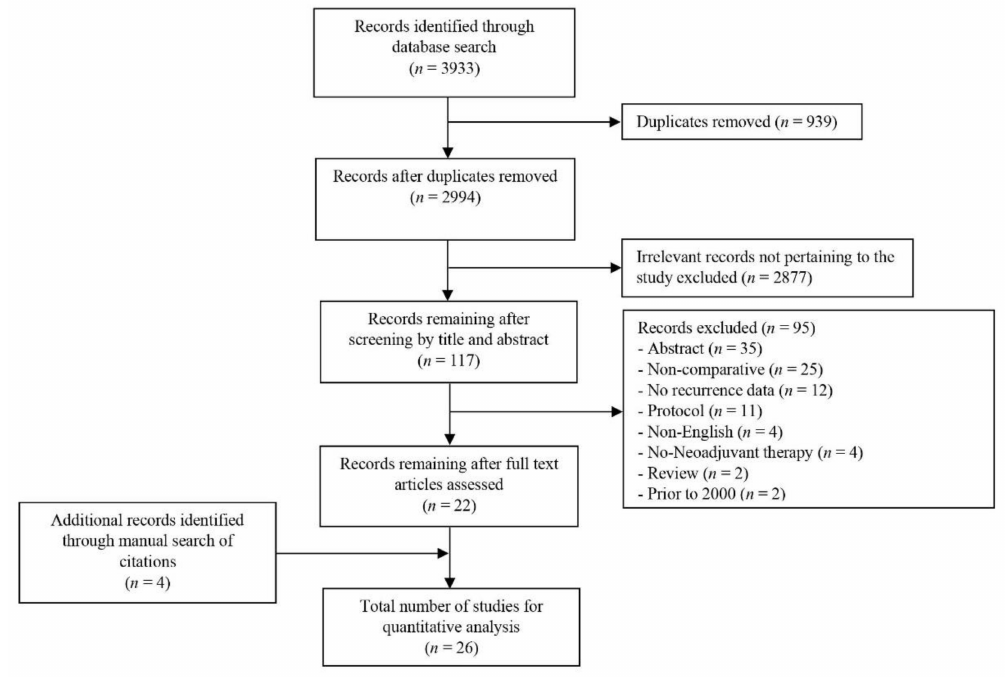
Figure 1. PRISMA flow chart of literature search